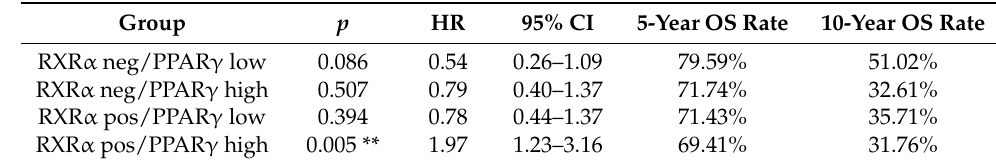
Table 3. Cox univariate survival analyses for hazard ratio (HR) determination and p values in the whole cohort of BC